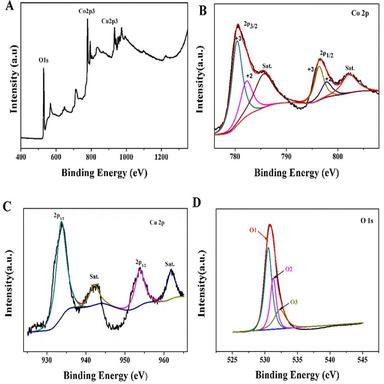
XPS spectra of CuCo2O4 dandelion, (A) survey scan, (B) Cu2p, (C) Co2p, and (D) O1s.